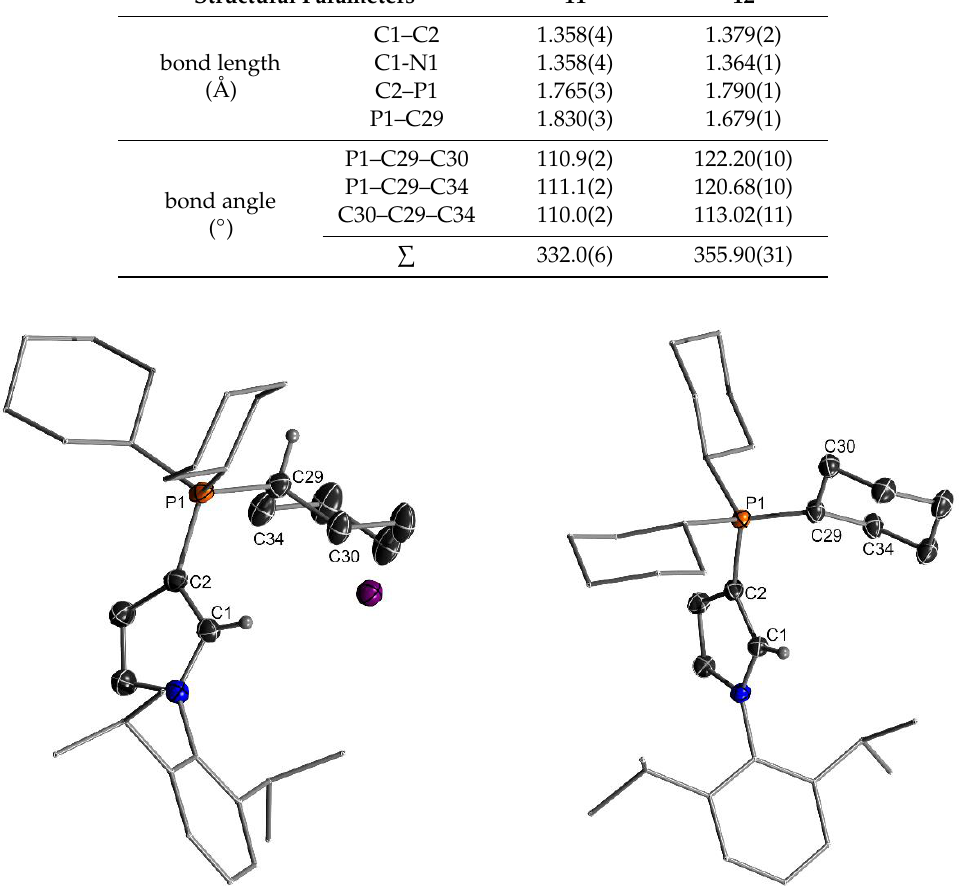
Table 1. Comparison of the bond lengths in 11 and 12 .